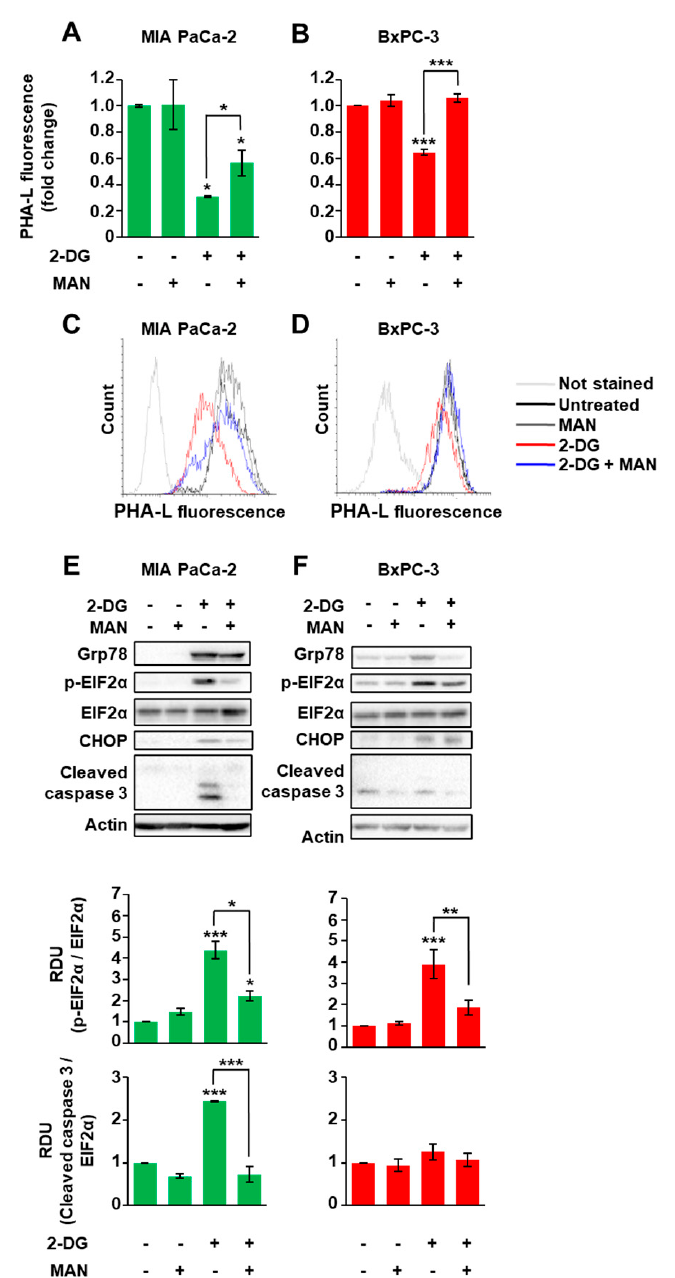
Figure 3. KRASmut MIA PaCa-2 cells are more sensitive than KRASwt BxPC-3 to the alteration of the N -glycosylations and the resulting endoplasmic reticulum (ER) stress. ( A – D ) Protein N -glycosylations were detected in viable MIA PaCa-2 ( A , B ) and BxPC-3 ( C , D ) cells after 72 h treatment with 2.5 mM 2-DG − /+ 1 mM mannose (MAN). In particular, tri-/tetra-branched N -glycans were recognized by FITC-conjugated PHA-L. The quantification of the mean fluorescence of independent experiments is displayed in the histograms ( A , B ), while representative flow cytometric profiles are shown in panels ( C , D ). ( E , F ) The expression of the UPR markers was analyzed through Western blot in MIA PaCa-2 ( E ) and BxPC-3 ( F ) cells treated with 2.5 mM 2-DG − /+ 1 mM MAN. Actin was used for signal normalization. The images are representative of at least three independent blots. The quantification of the EIF2 α phosphorylation and Cleaved Caspase 3, considering all experiments performed, is displayed in the histograms on the bottom. All data represent the mean ± SEM of at least three independent experiments. * p < 0.05, ** p < 0.01 and *** p < 0.001 (One-way ANOVA), untreated vs. treated where not specifically